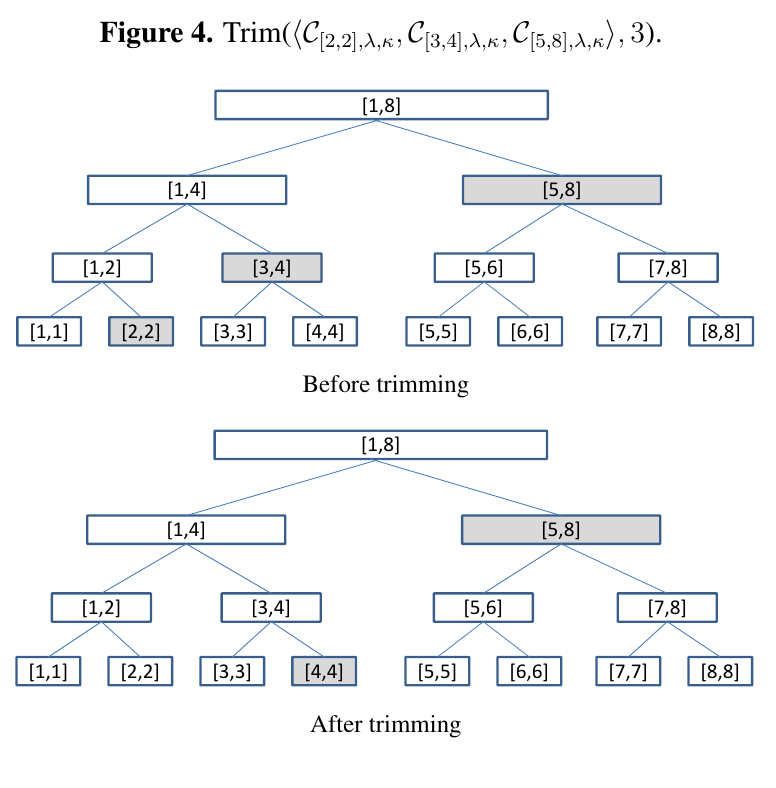
Figure 4. Trim( (cid:104)C